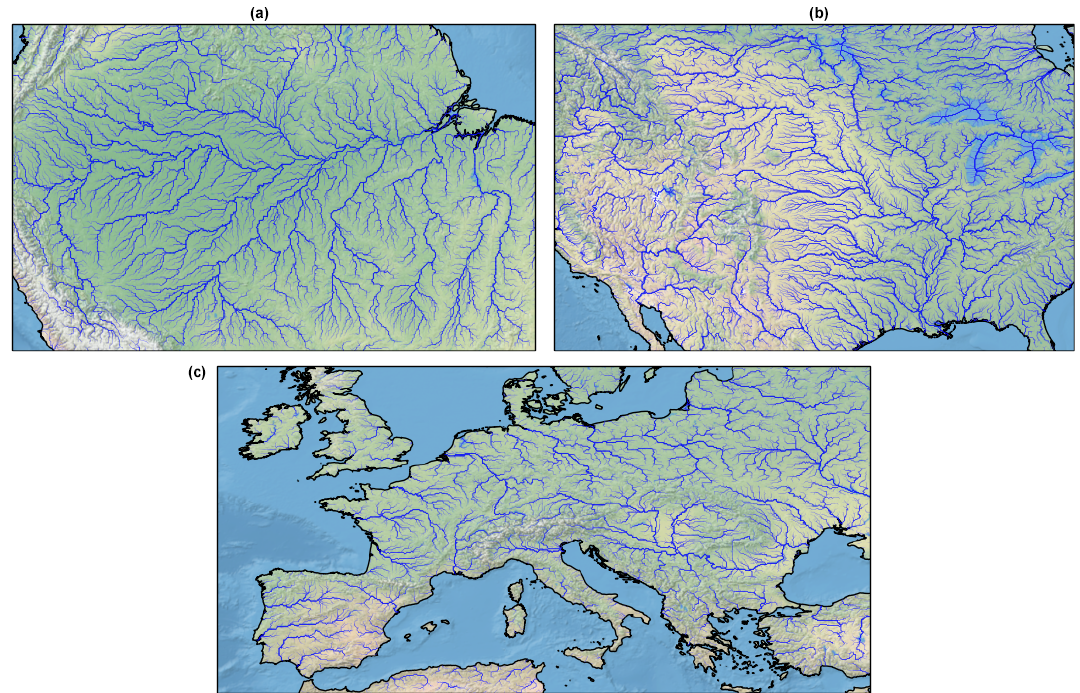
Figure 6. Regional-scale river network at 1 / 12 ◦ resolution: the Amazon basin (a) , North America (b) and Europe (c)